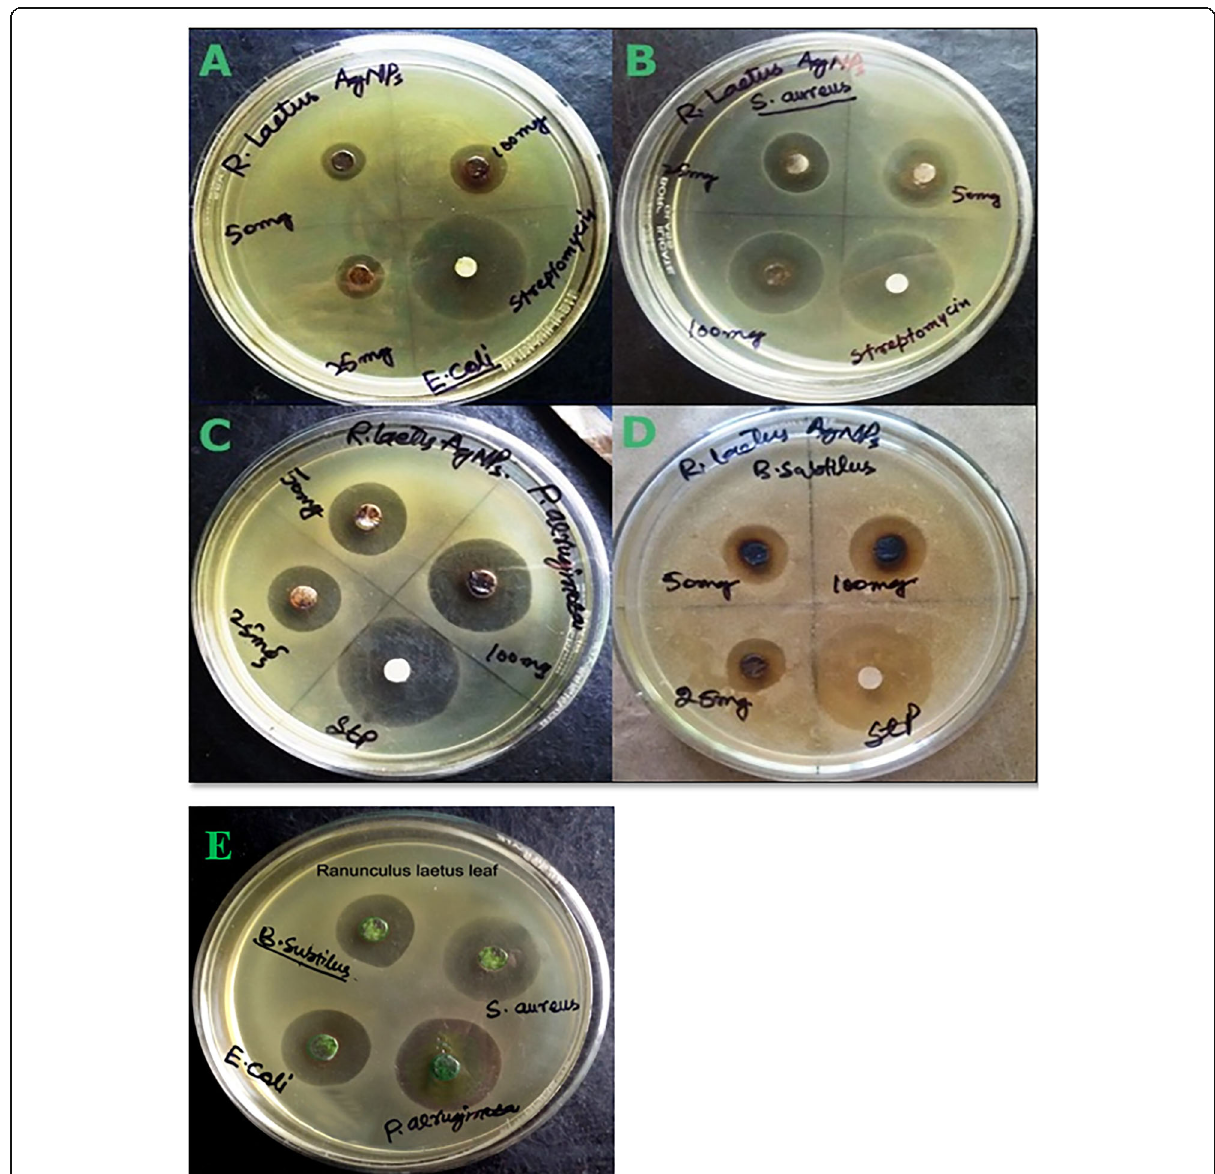
Fig. 7 R. laetus -mediated AgNPs. Zone of inhibition of against a E. coli , b S. aureus , c P. aeruginosa , d B. subtilis , and e Antibacterial activity of R. laetus aqueous leaf extract Table 3 MIC of R. laetus- mediated silver nanoparticles Concentration